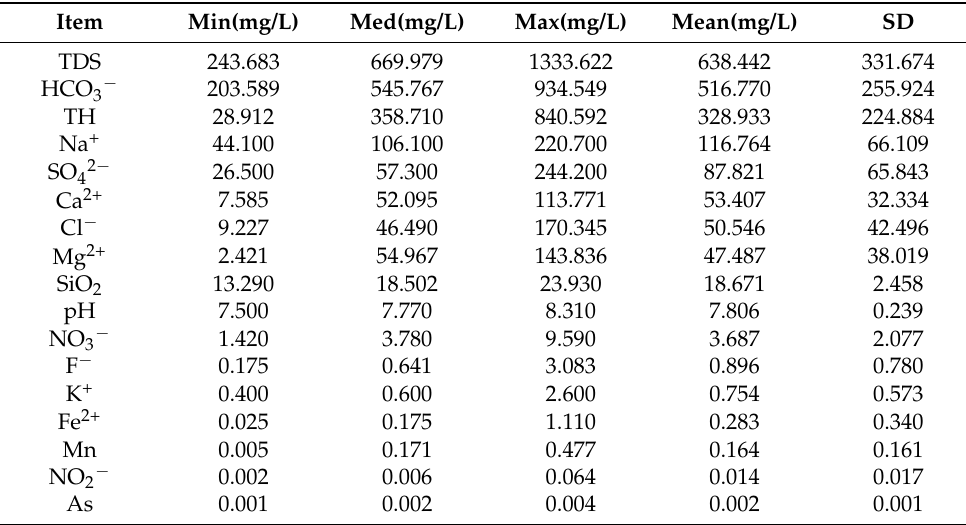
Table 1. Descriptive statistics of chemical parameters of